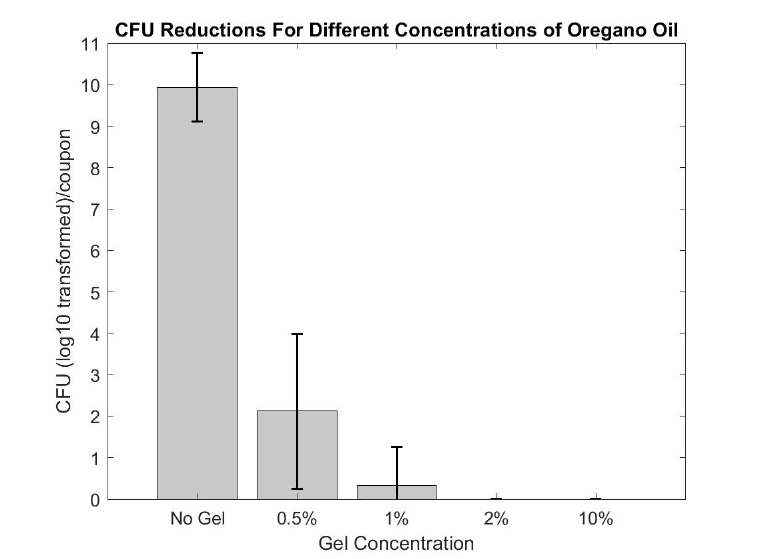
Figure 5. Various concentrations of oregano oil were tested to determine the ideal amount of oregano to use in the multi-day studies. 2% oregano and upwards caused complete eradication of the biofilm (within detectable limits).